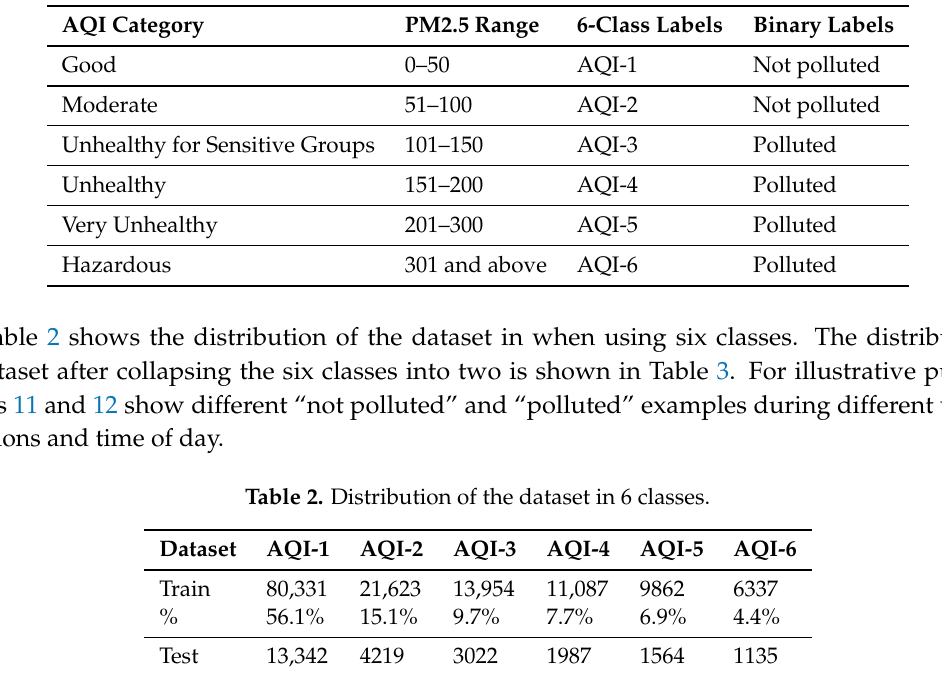
Table 1. Air Quality Index (AQI) categories based on ranges of PM2.5 values and mapping to labels in the different classification problems.